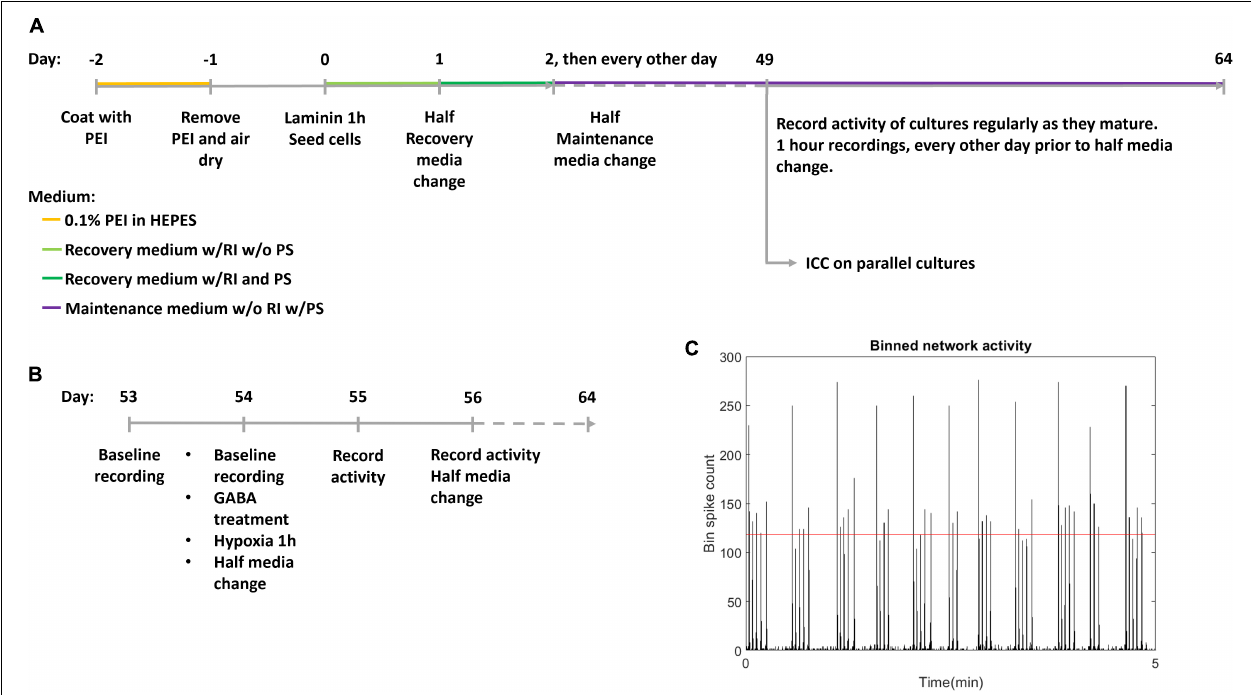
FIGURE 1 | Experiment timeline. (A) The experimental timeline. Cells were seeded on day 0 after coating with polyethyleminine (PEI) and laminin. RI: Rock inhibitor Y-27623 2HCL, PS, Penicillin-Streptomycin antibiotics; ICC, Immunocytochemistry. (B) Detailed timeline of hypoxic challenge. Following day 56 activity was recorded every day, and media was half replaced every other day. (C) Network bursts were identified by bins of high firing rate, with the threshold indicated by the red horizontal line.